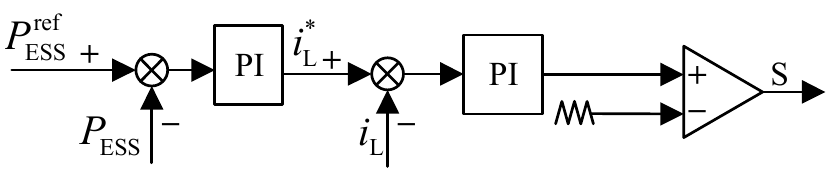
Figure 9. Control structure diagram of DC/DC converter.